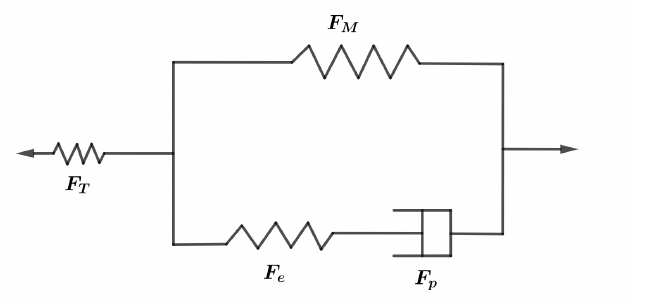
Figure 2. A linear thermoviscoelastic rheological